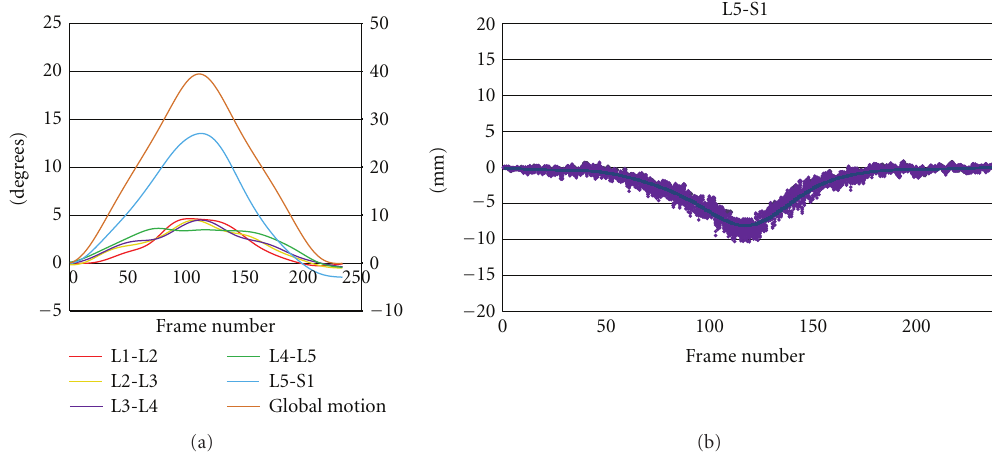
Figure 5: (a) Continuous intervertebral angles for 5 levels (left y -axis) and global (trunk) motion (right y -axis) in a patient with unstable L5-S1 spondylolytic spondylolisthesis. (Passive recumbent extension motion, note excessive motion at L5-S1, with irregular motion at L3-4 and L4-5. Maximum L4-5 range attained before maximum global motion range). (b) Translational motion path at L5-S1 extension in the same image sequence as in 5(a). (Solid line is mean translation and shaded area is all data). Note translational range of 8mm.